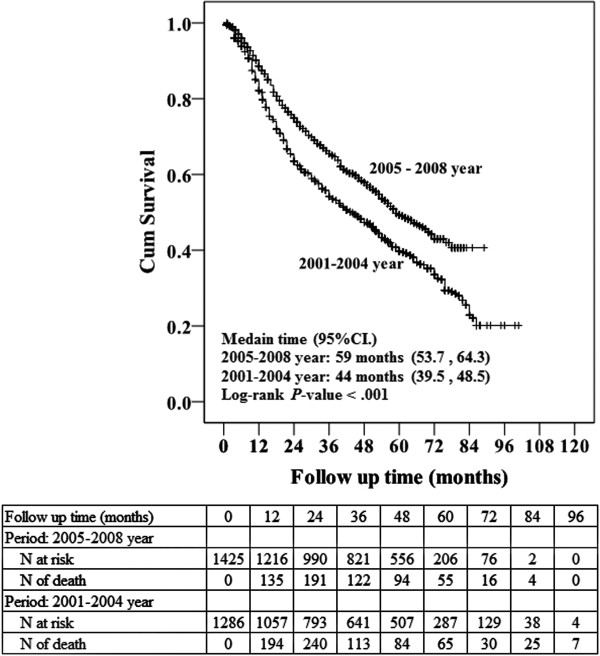
Kaplan-Meier curves of overall survival (OS) for time period 2001 to 2004 (more surgeons performed lymph node sampling) (blue line) and 2005 to 2008 (more surgeons performed complete resection) (green line) (+indicates censored cases). P < 0.001 indicates OS was significantly different between the 2 periods.